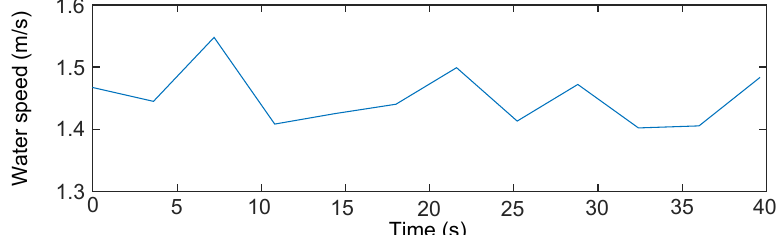
Figure 1. Water velocity upstream of the Söderfors turbine on 16 April